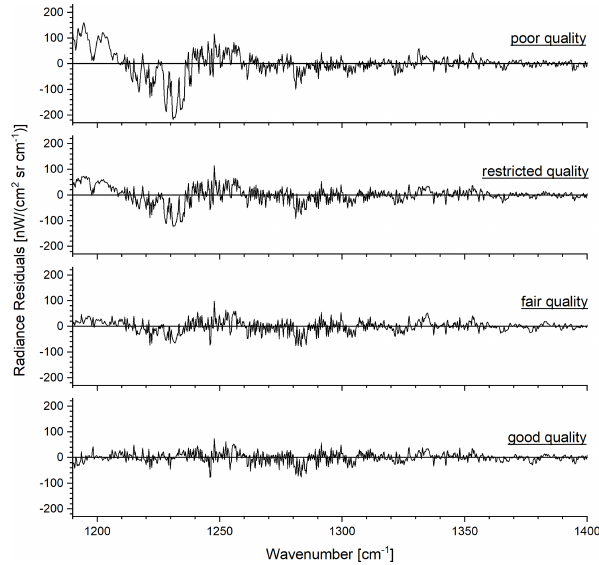
Figure 13. Example of residuals (simulated − measured spectra) belonging to the different quality groups as documented by the variable musica_fit_quality_flag : poor, restricted, fair, and good. The retrievals correspond to observations over northern Africa with relatively high but very similar surface skin tempera- ture (319.1–319.3K) made during the Metop-A orbit no. 51267 as shown on the left of Fig.